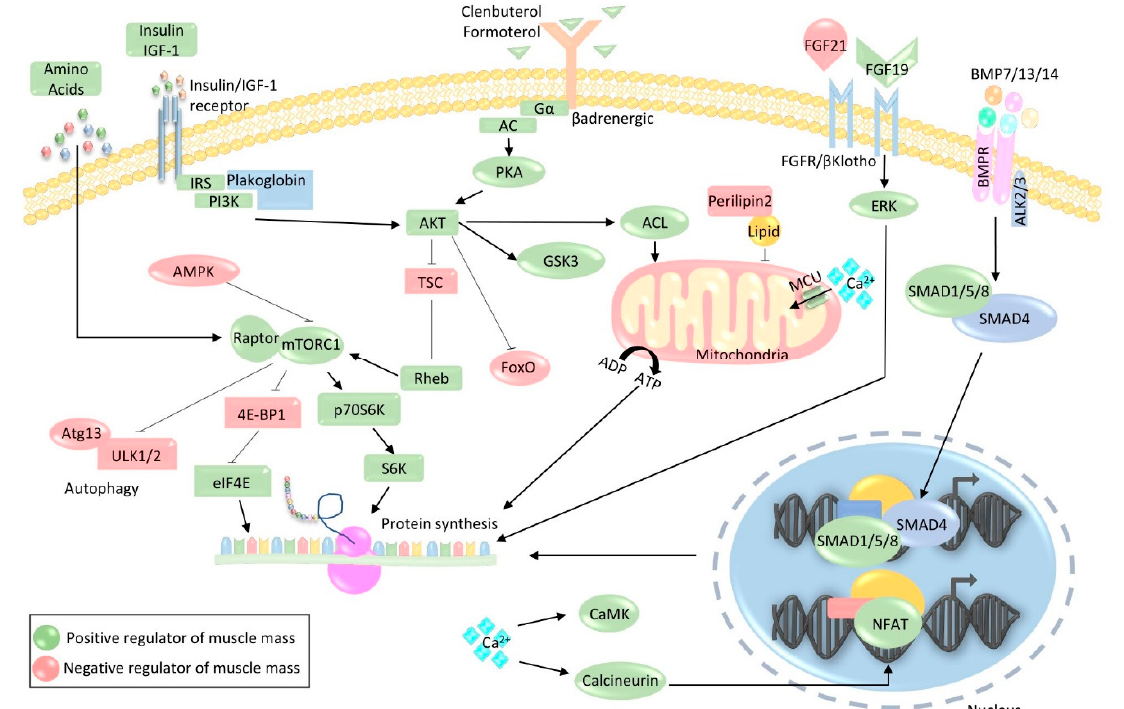
Figure 1. Pathways involved in protein synthesis. During muscle hypertrophy, the binding of insulin-like growth factor 1 (IGF-1) / insulin to their respective receptors activates IRS–PI3K–Akt–mTORC1 signaling, which is further stimulated by the presence of amino acids. The mTORC1 complex then enhances protein synthesis by inhibiting the eukaryotic translation initiator factor 4E (eIF4E) inhibitor 4E-binding protein 1 (4E-BP1) and activating p70S6K-S6-mediated protein translation. mTOR also blocks proteolysis by inhibiting autophagy initiation factors Unc-51 like autophagy activating kinase (ULK) 1 / 2. Clenbuterol and formoterol promote hypertrophy by binding to the adrenergic receptor and activating adenylate cyclase (AC)-PKA signaling, which culminates in the activation of Akt-mTOR. In addition to enhancing protein synthesis, Akt also blocks proteolysis by phosphorylating and inhibiting members of the forkhead box O family of transcription factors (FoxO), as well as activating glycogen synthase kinase (GSK) 3 and ATP citrate lyase (ACL). Fibroblast growth factor (FGF)19 enhances protein synthesis by binding to the β Klotho receptor and stimulating the extracellular signal-regulated kinase (ERK), which directly contributes to protein synthesis. Moreover, the binding of bone morphogenetic protein (BMP)7 / 13 / 14 to the BMPR receptor promotes muscle growth through the formation of a SMAD1 / 5 / 8–SMAD4 complex, which activates a hypertrophic transcriptional program. Calcium signaling also contributes to hypertrophy through the activation of calmodulin (CaM)-dependent kinase (CaMK) and phosphatase calcineurin, which stimulates the pro-growth transcription factor nuclear factor of activated T-cell (NFAT). Increased availability of nutrients and energy in the form of ATP further contribute to the auspicious environment that is permissive for muscle growth. Green shapes indicate positive regulators of muscle mass, whereas red shapes indicate negative regulators.